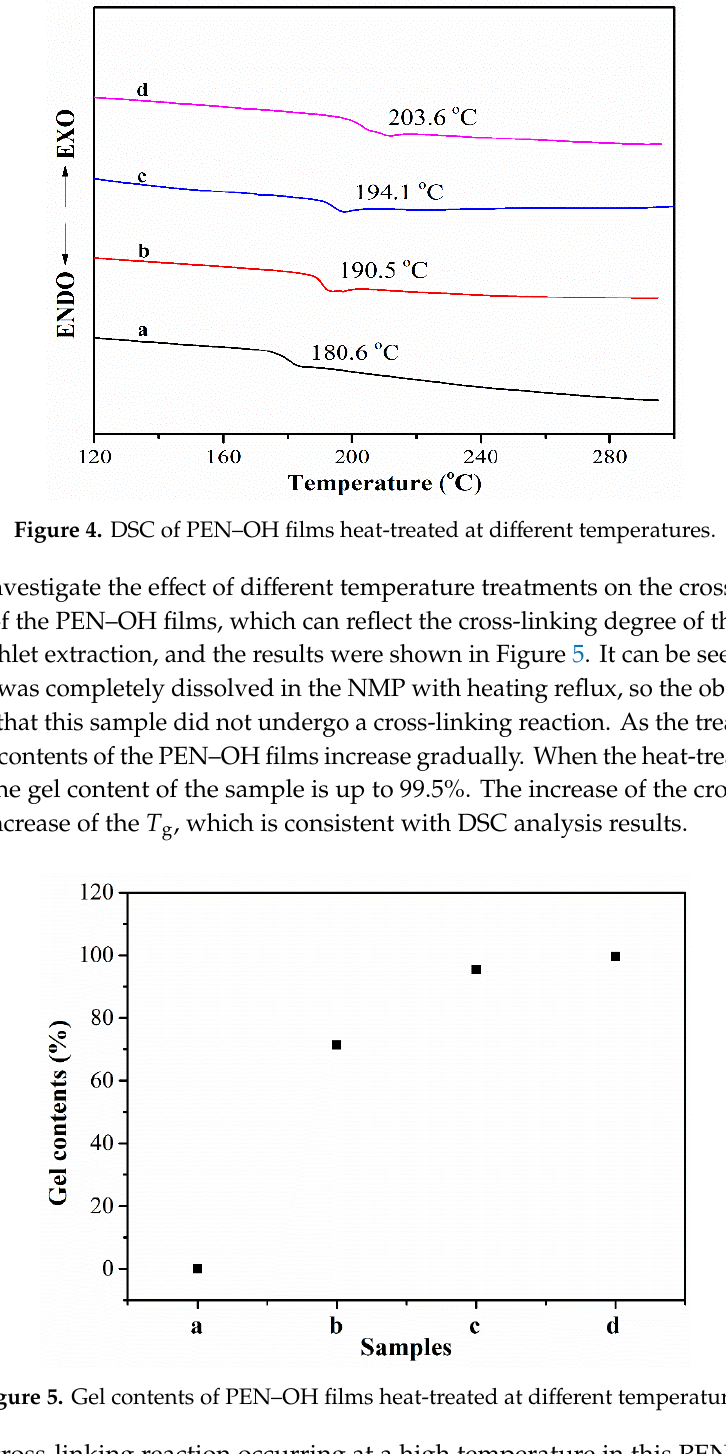
Figure 5. Gel contents of PEN–OH films heat-treated at different temperatures.